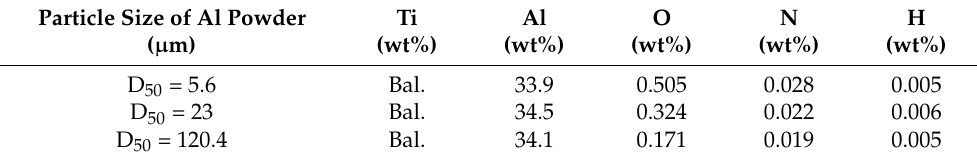
Table 2. Chemical composition of sintered TiAl samples (wt.%, Bal. is short for balance). Particle Size of Al Powder ( µ